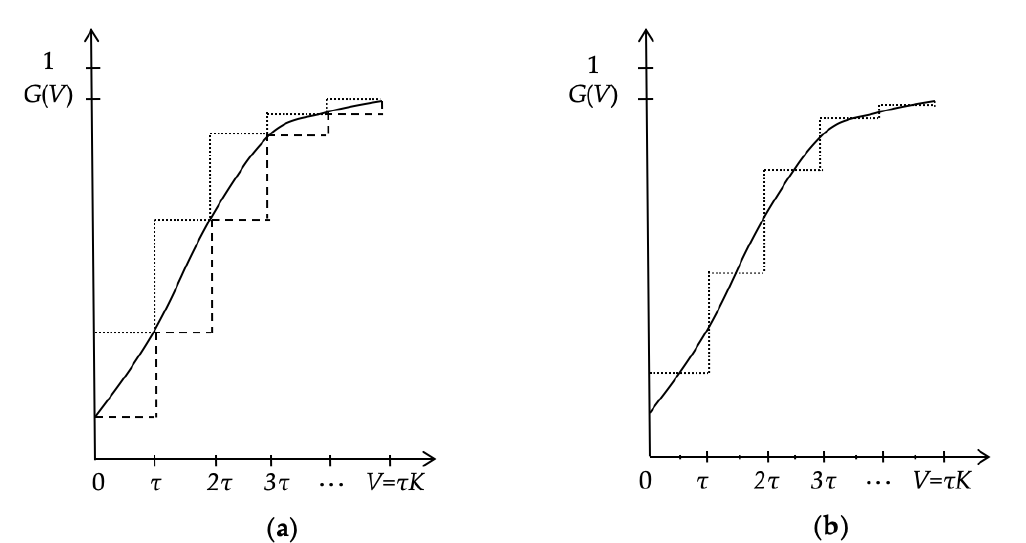
Figure 1. The resource requirement cumulative distribution function (CDF) G ( x ) (solid line) and its approximations: ( a ) dashed line – F 1 ( x ) , dotted line – F 2 ( x ) ; ( b ) dotted line – F 3 ( x ) .